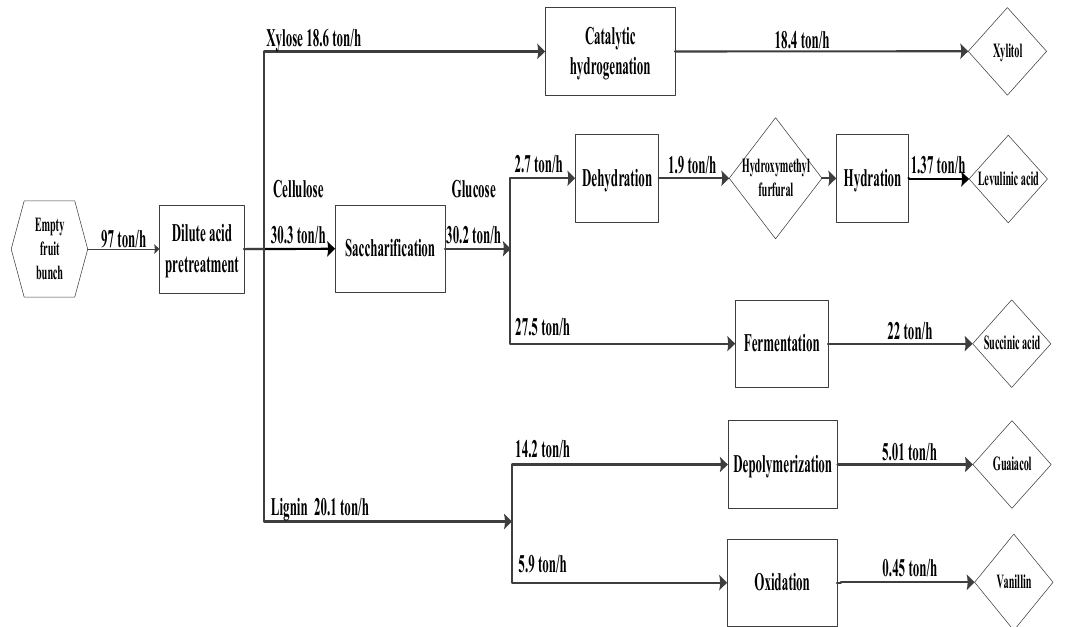
Figure 7. The biorefinery configuration of the optimal point S3 for profit and global warming potential objectives.